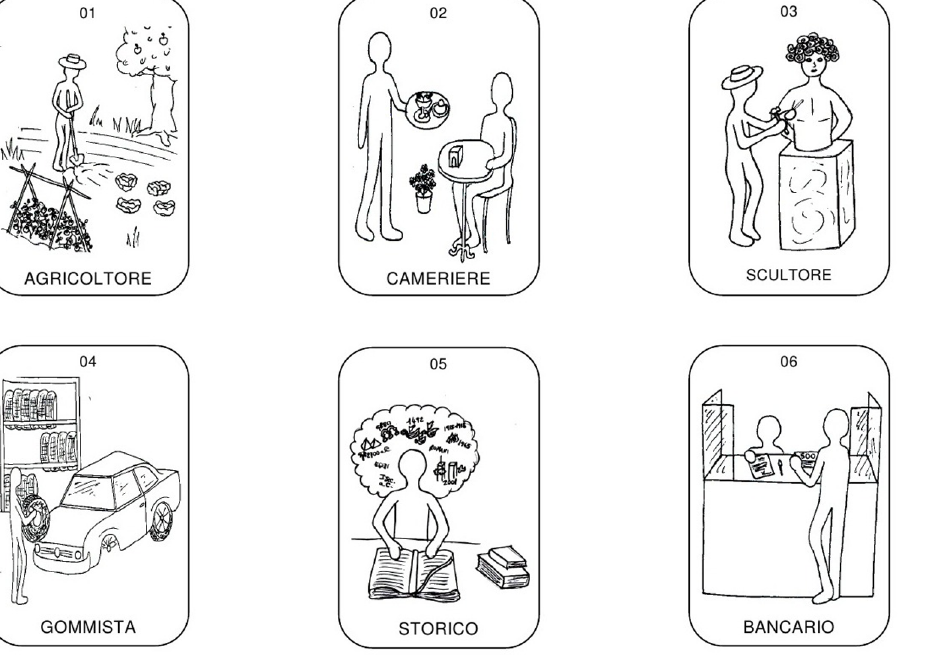
Figure 1. Examples of